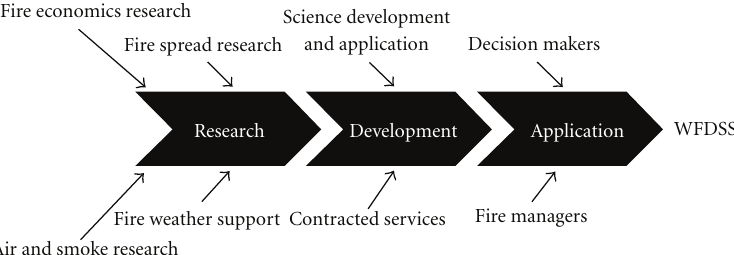
Figure 5: Schematic of personnel involved in the research, development, and application of WFDSS.